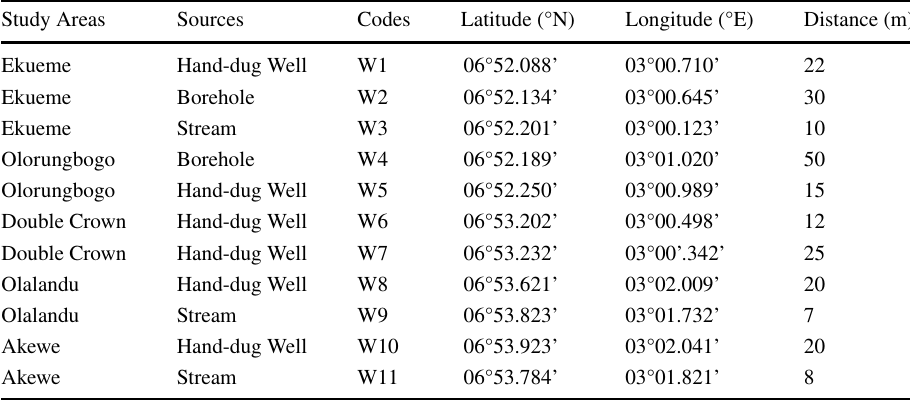
*Distance: Distance from the cassava